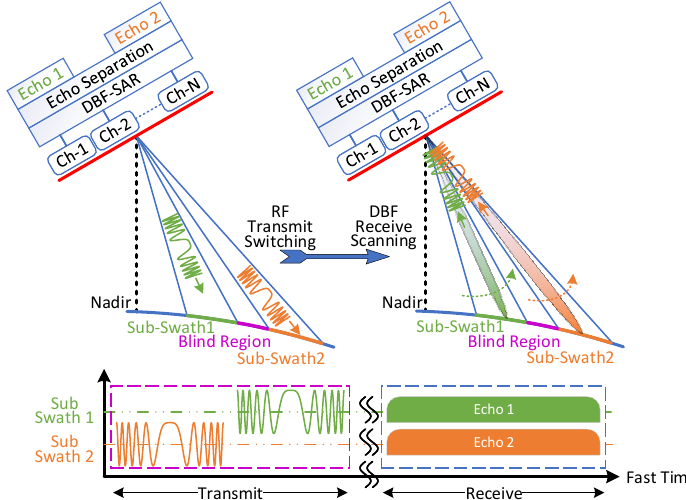
Figure 1. The principle diagram of a typical two-sub-swath STWE-SAR